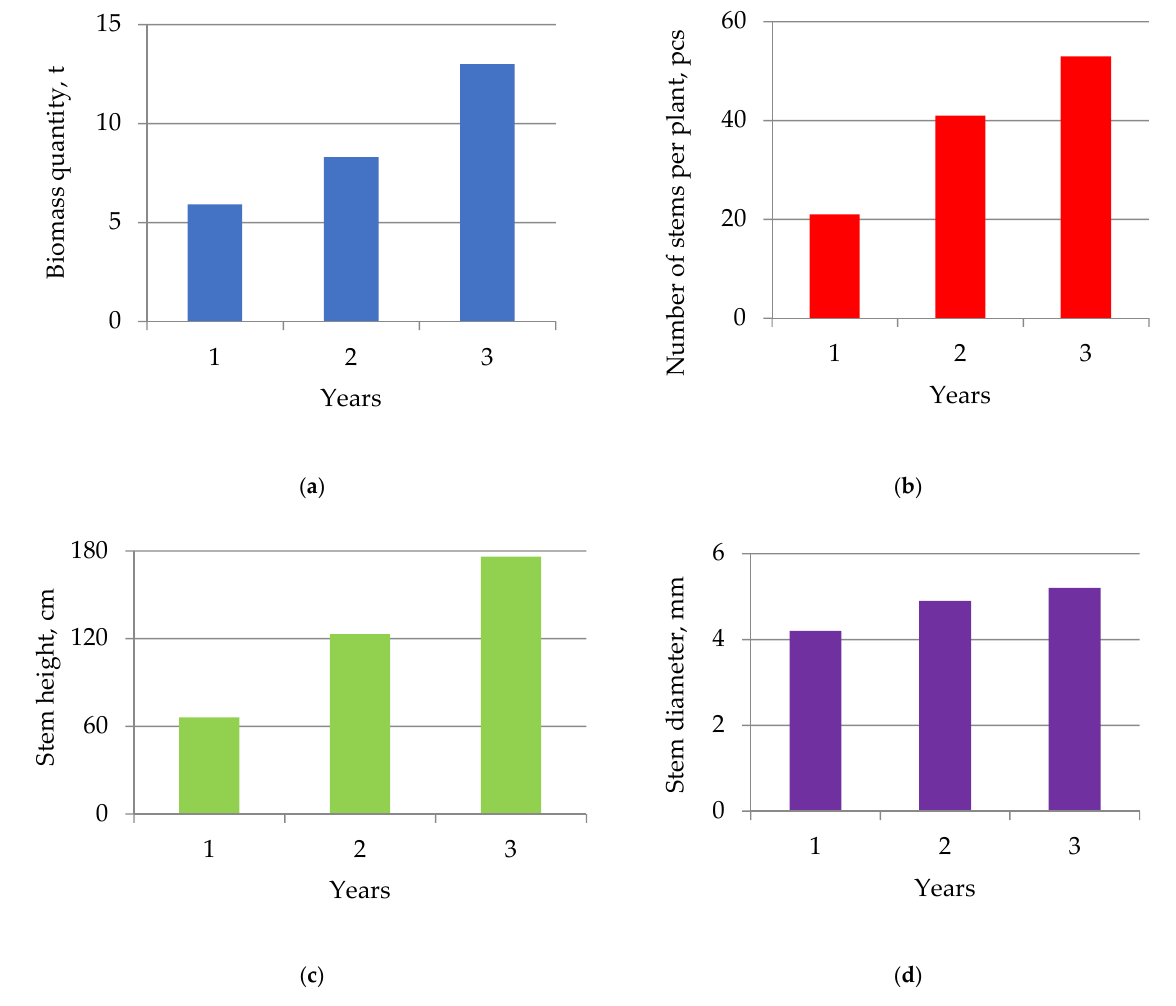
Figure 2. Influence of age on the condition (( a ) biomass quantity, ( b ) number of stems per plant, ( c ) stem height, and ( d ) stem diameter) of the aboveground part of miscanthus (the figure is based on the data from [41]).